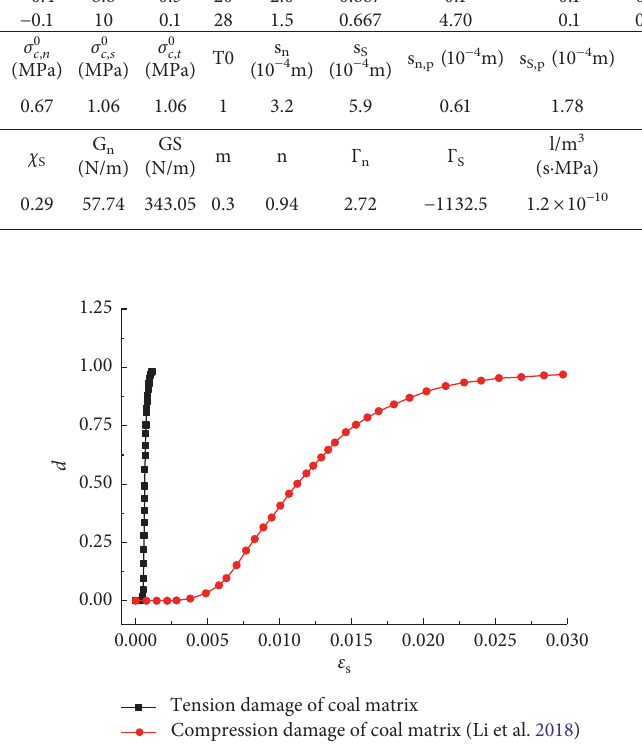
Figure 7: Damage mechanical properties coal matrix.